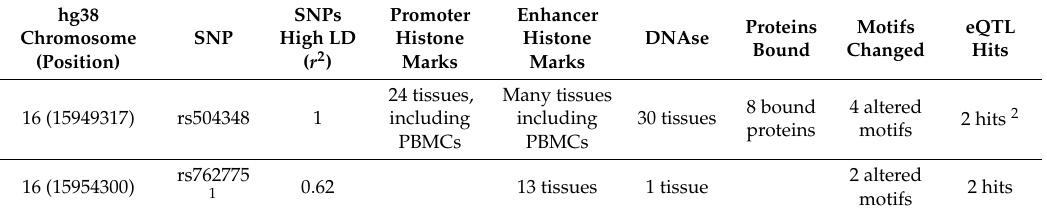
Table 5. In silico predictions for rs504348 and variant (rs762775) in high linkage disequilibrium